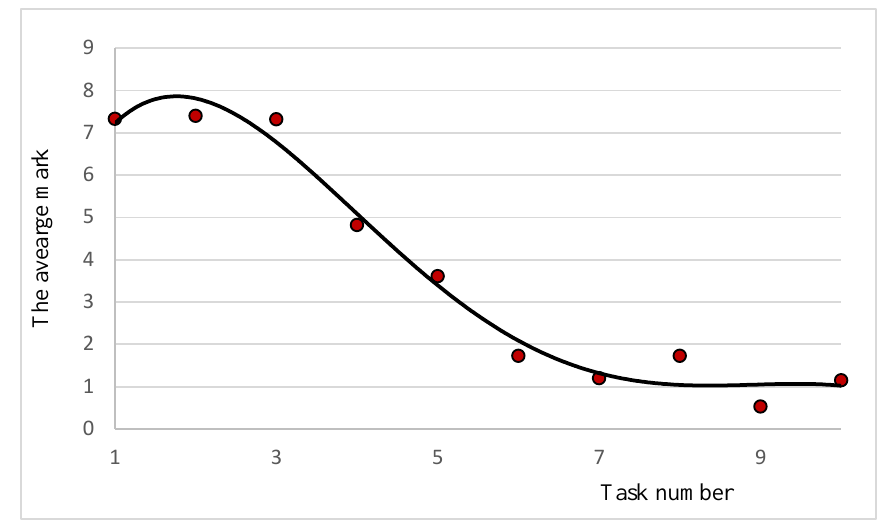
Fig. 3. Average mark at the SM department in